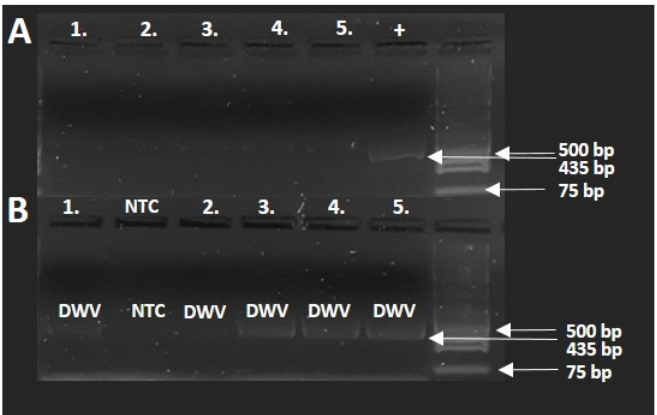
Figure 6. Results of the gel electrophoresis of RT-PCR honey bee samples. ( A ): Healthy specimens; ( B ): distorted specimens; +: positive control; NTC: non-template control.